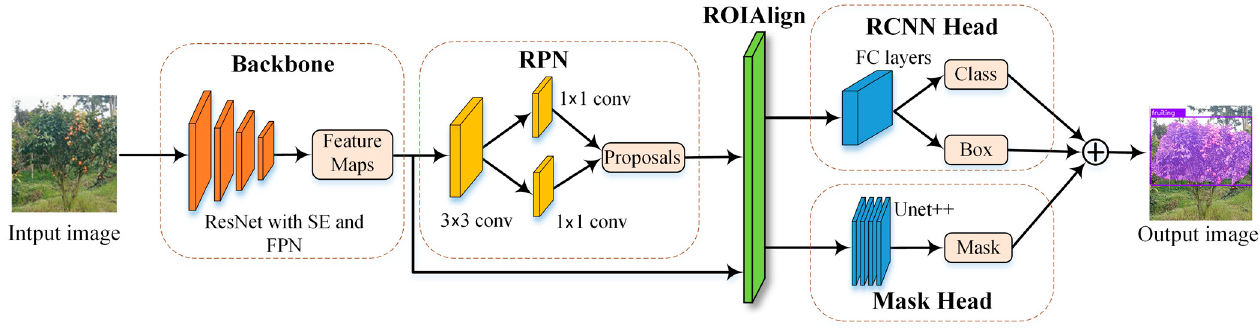
Figure 5. MSEU R-CNN network structure.